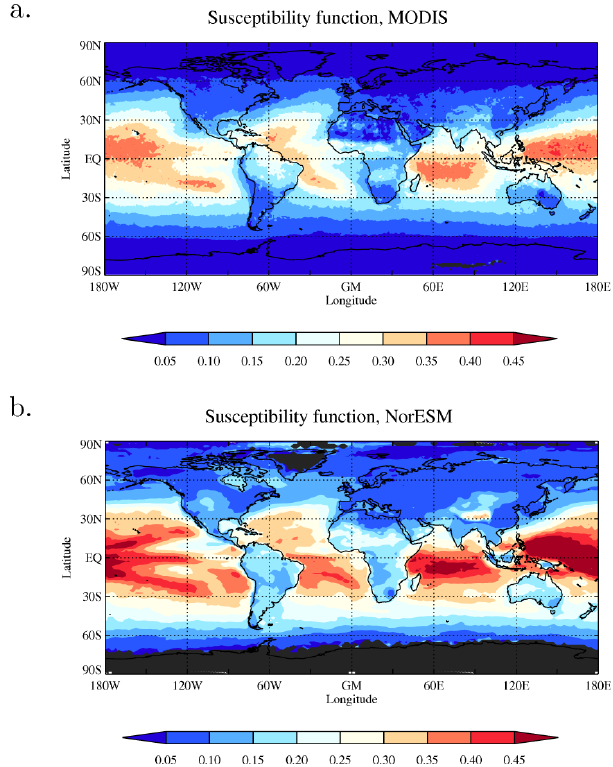
Fig. 1. Annually averaged susceptibility (Eq. 5) from (a) MODIS data and (b) NorESM